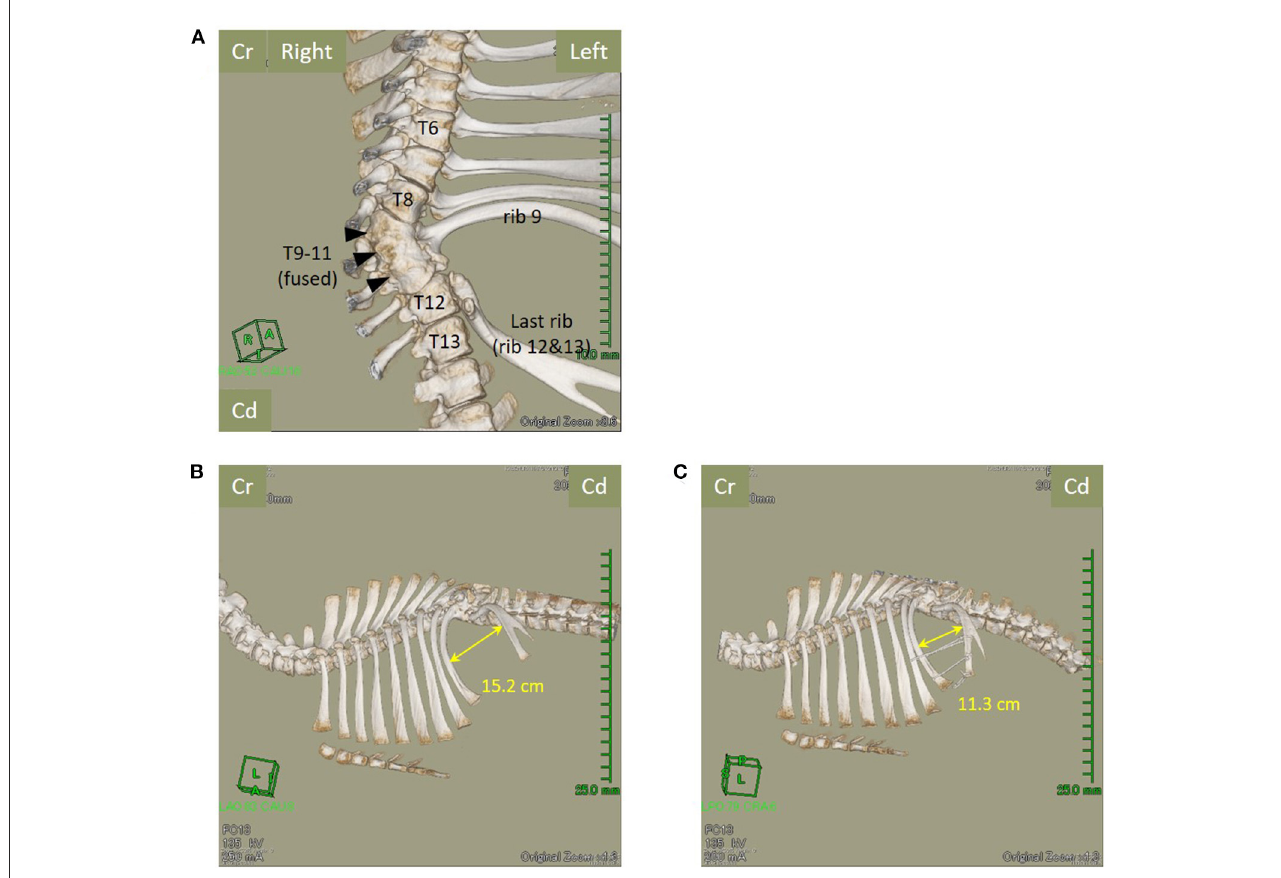
FIGURE2 The fusion of the 9th, 10th, and 11th thoracic vertebrae (arrowheads) and loss of the left-sided rib, with the right-sided rib being partially erased (ventral view). (A) The 11 left-sided ribs, the last rib (12th and 13th ribs), and the maximum intercostal width of the hernial foramen reduce from 15.2cm (B) before surgery to 11.3cm (C) after surgery. Cr, Cranial; Cd, Caudal; T, Thoracic vertebra.